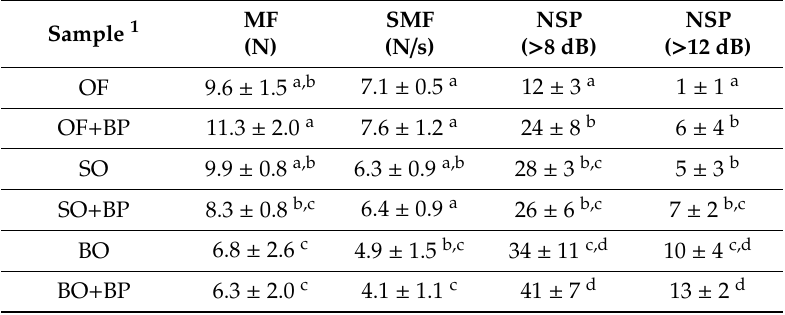
Table 1. Mean values of maximum peak force (MF), slope at maximum peak force (SMF), and the number of sound peaks (NSP) above the 8 and 12 dB thresholds, measured during fragmentation of the biscuits using a three-point bending